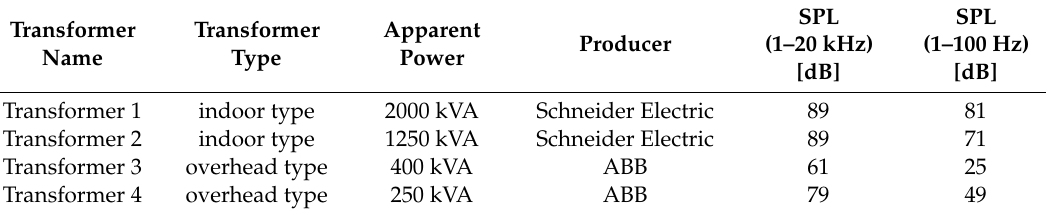
Table 1. The list of power transformers under